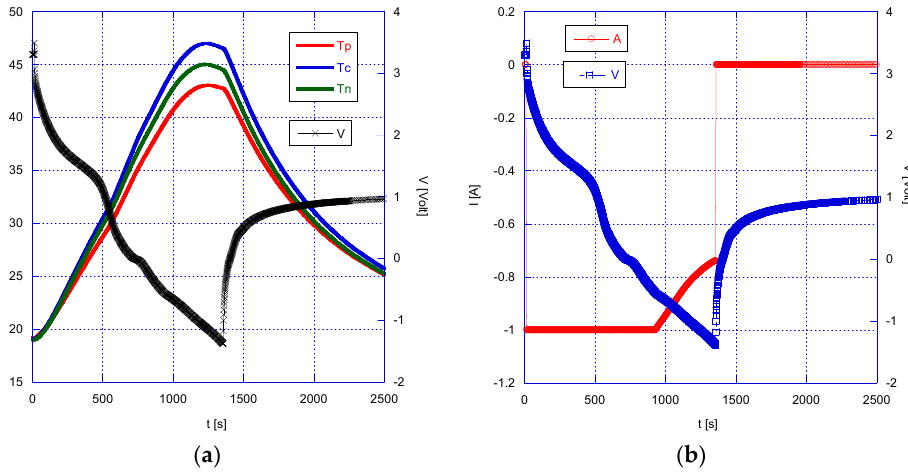
Figure 5. Graphite anode cells. Overdischarge test, DOD% = 110%: ( a ) temperature and voltage trend of the abused cell, ( b ) current and voltage trends of the abused cell.